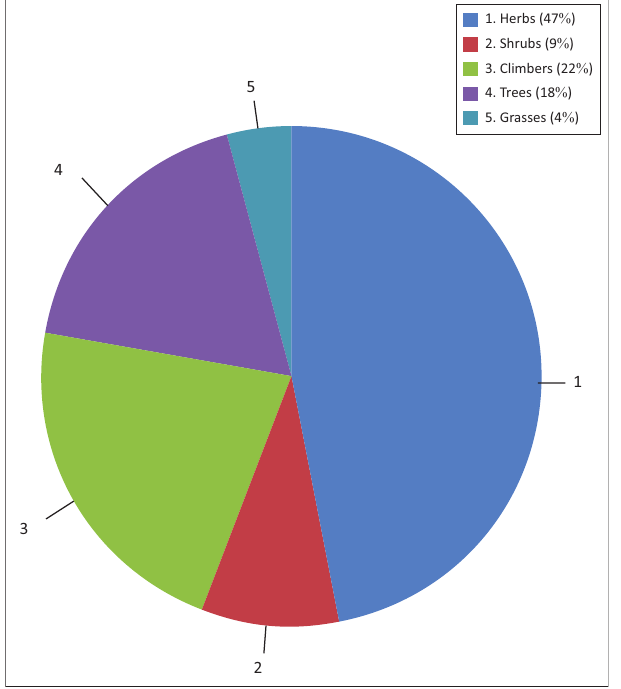
FIGURE 5: (a) Origin of medicinal plants and (b) social welfare of plant